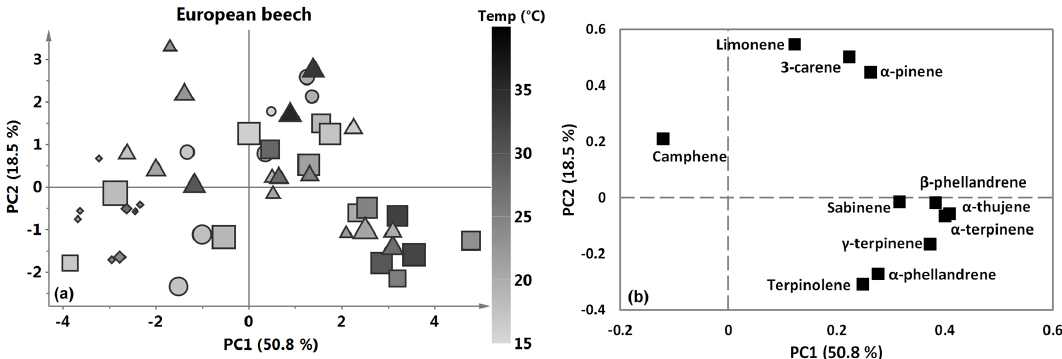
Figure 8. Principal component analysis on the BVOC emission from four cloned individual European beech trees growing at three sites. (a) The scores of the principal components (PC1 and PC2), and (b) the corresponding loading variables. In (a) , the shading explains the average air temperature. The size of the symbols depicts the average daily PAR level, with an increasing symbol size with increasing PAR levels. The symbols show samples from the different sites (circle = Ljubljana, square = Grafrath tree one, triangle = Grafrath tree two, diamond = Taastrup). The explained variance for the different PCs is shown in